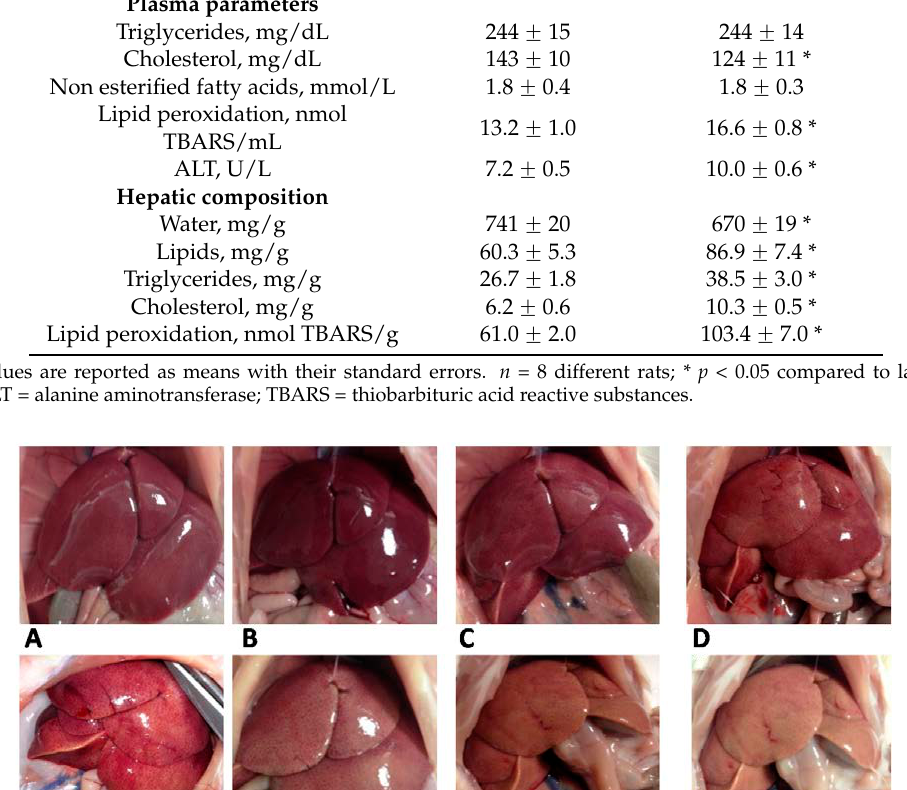
Table 3. Plasma parameters and liver composition in rats fed lard or safflower-linseed high fat diet. Lard Safflower-Linseed